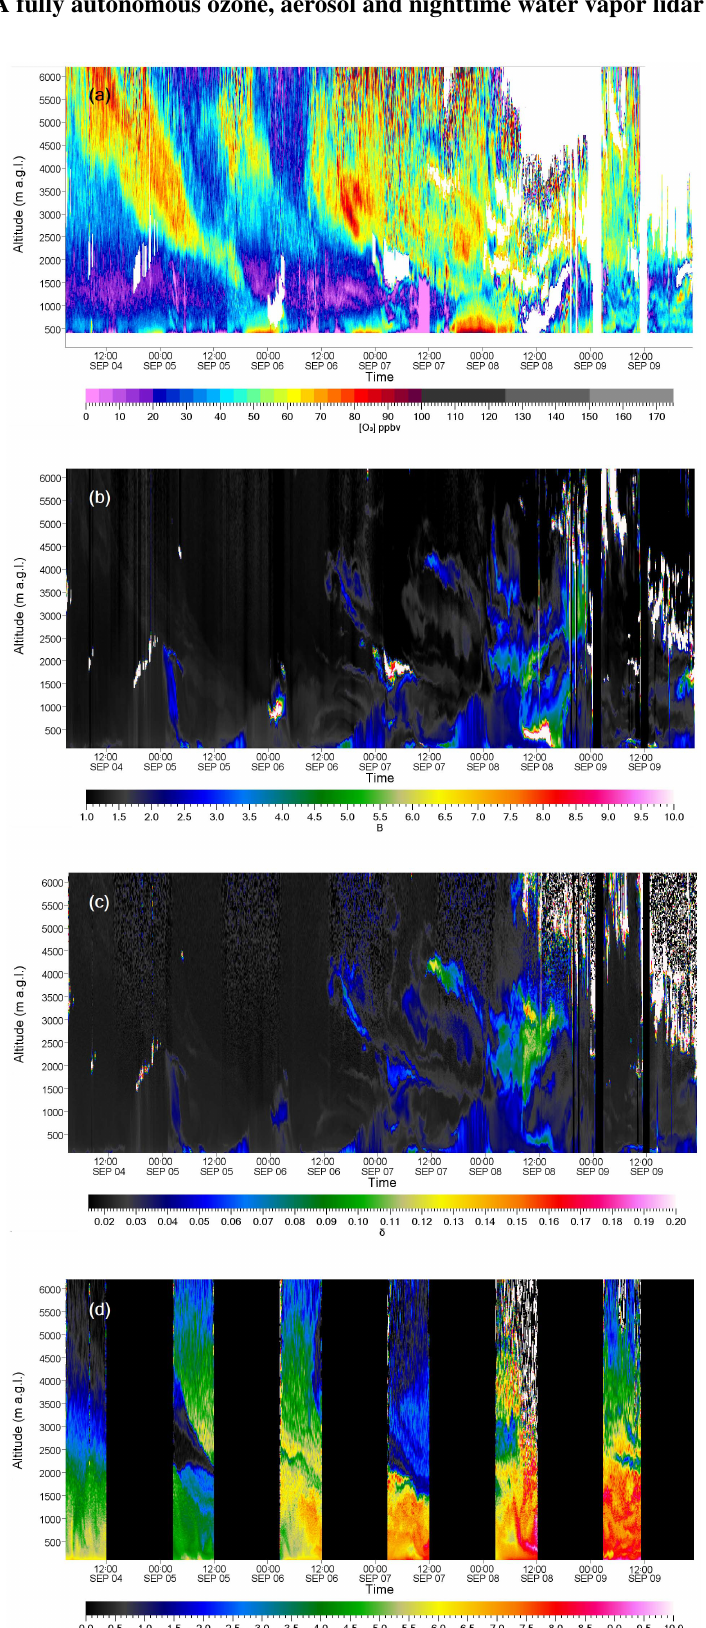
Figure 18. False-color lidar plots for 4–9 September for (a) ozone, (b) backscatter ratio, (c) depolarization ratio and (d) water vapor (night- time